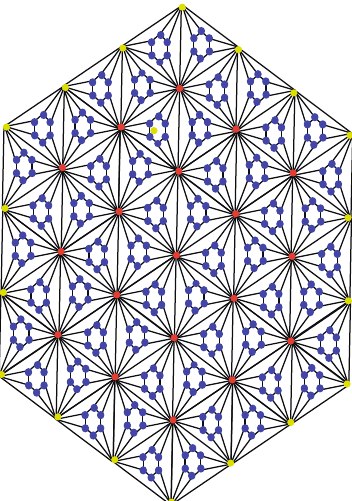
Figure 1: Fourth type of the hex-derived network (HDN4